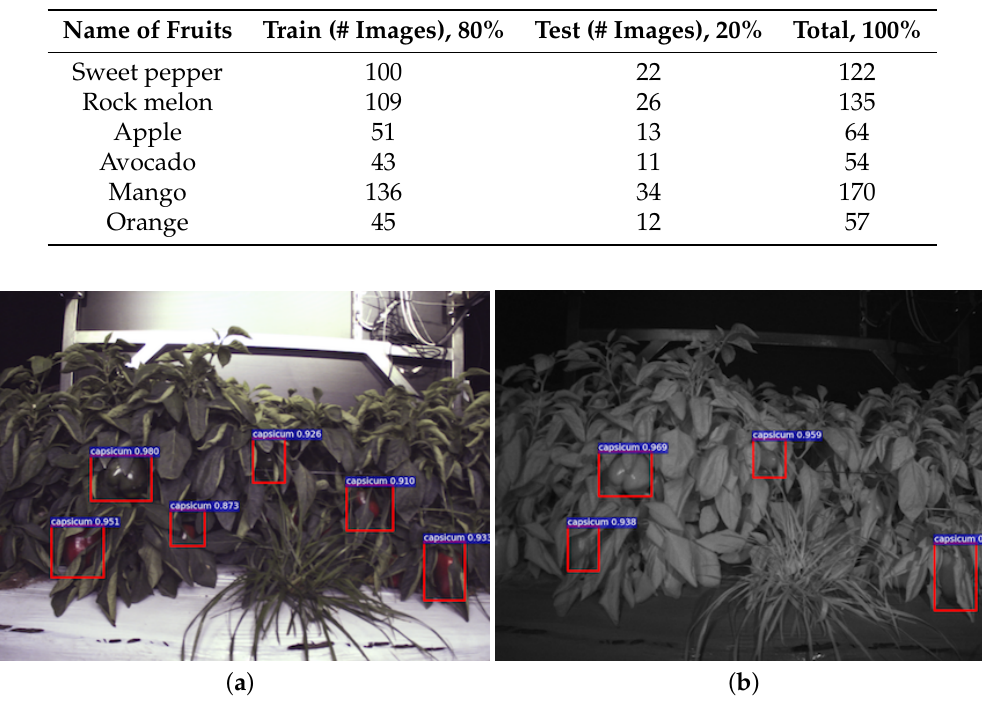
Figure 12. Instances of detection performance using the same camera setup as the training dataset and the same location. Above each detection is the classification confidence output from the DCNN. ( a , b ) The outputs from the RGB and NIR networks, respectively. It can be seen that there are noticeable F N (miss) in the NIR image, and colour and surface reflections play important roles in detection for this example.